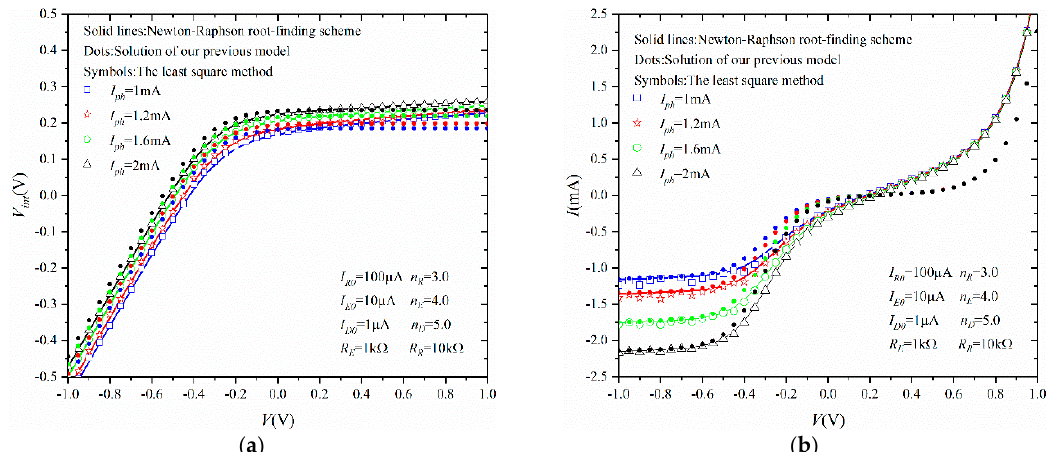
Figure 4. ( a ) V int ( V ) and ( b ) I ( V ) of the circuit in Figure 2 for different R R .